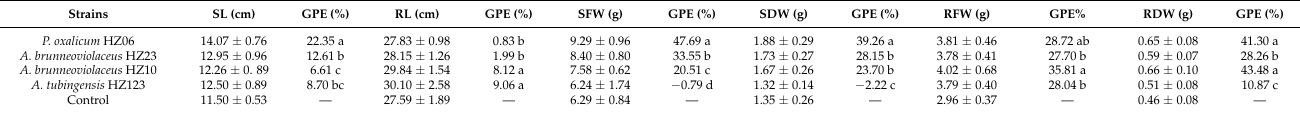
Means are averages ± standard deviations (SD). Values in a column with different letters are significantly different by Student’s t -test at ( p ≤ 0.05). SL: seedling length; GPE: growth promotion efficacy; RL: root length; SFW: seedling fresh weight; SDW: seedling dry weight; RFW: root fresh weight; RDW: root dry weight.